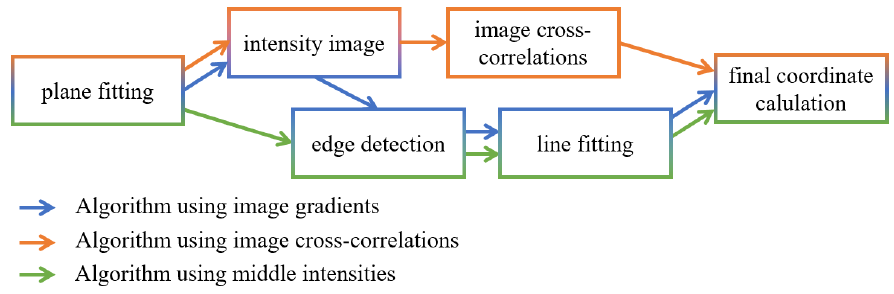
Figure 3. Workflow of the three algorithms described in Sections